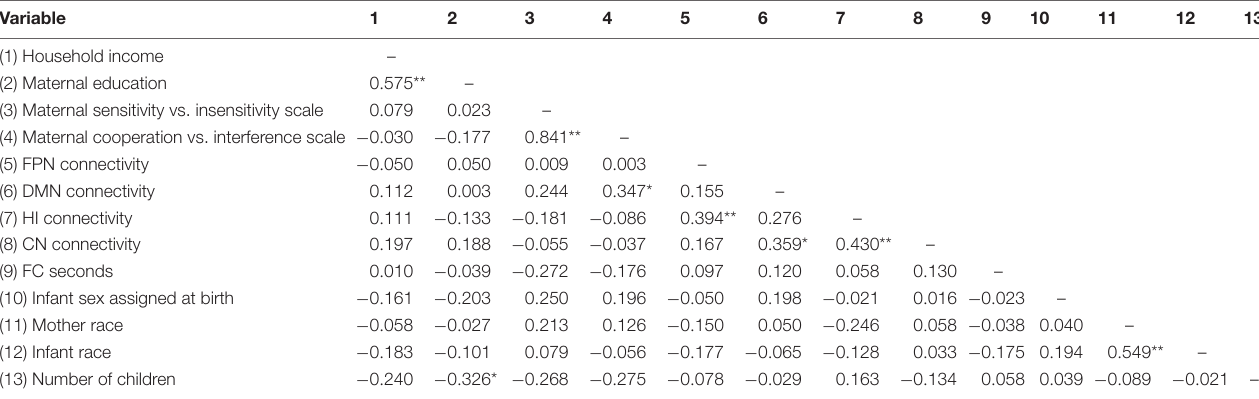
TABLE 2 | Correlations among study variables.